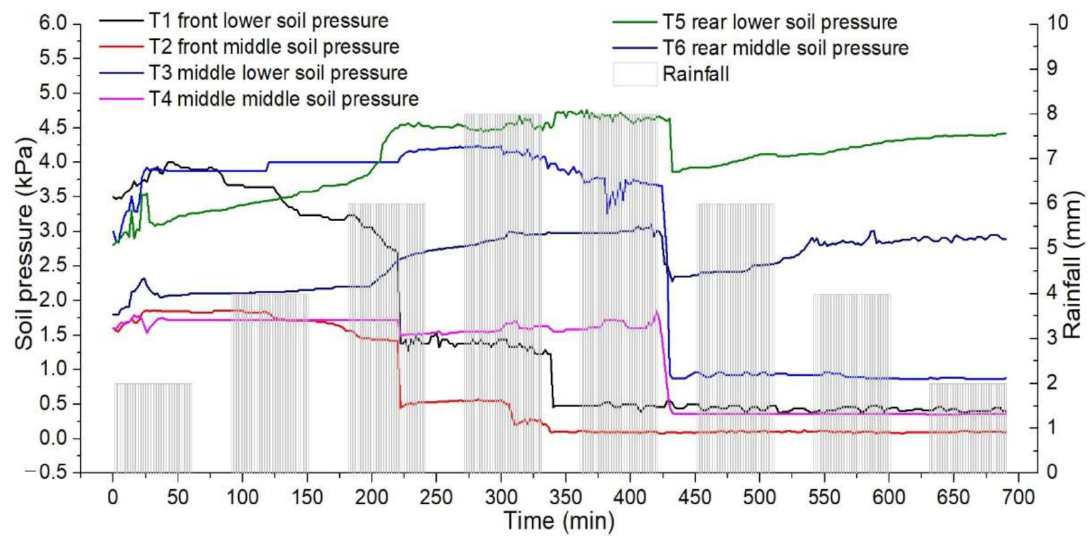
Figure 14. Earth pressure measurement time